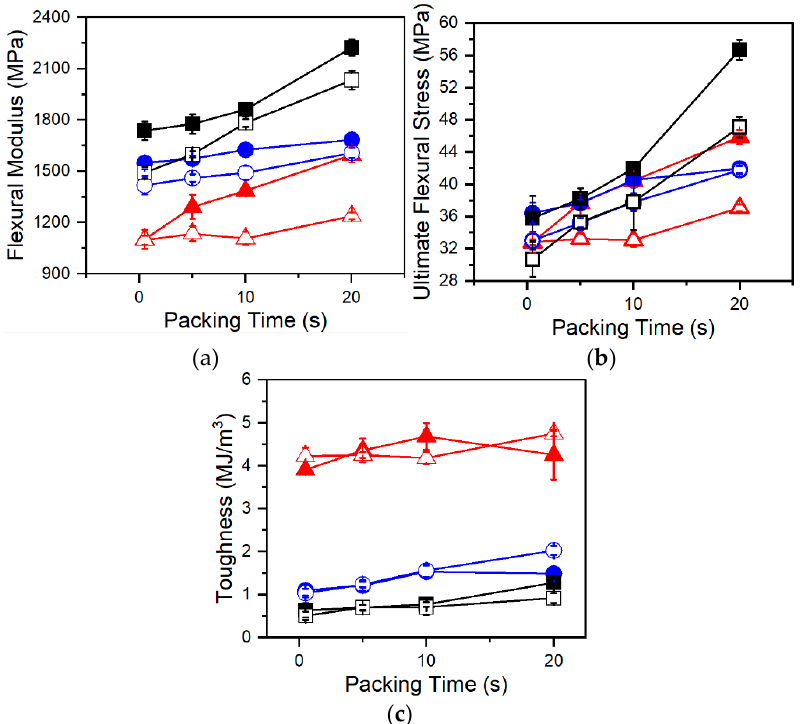
Figure 9. ( a ) Flexural modulus, ( b ) ultimate flexural strength, and ( c ) toughness of Resin A (red triangles), Resin B (blue circles), and Resin C (black squares) foamed at various packing times using UC CBA. Closed and open symbols indicate 1 wt% and 2 wt% CBA respectively.